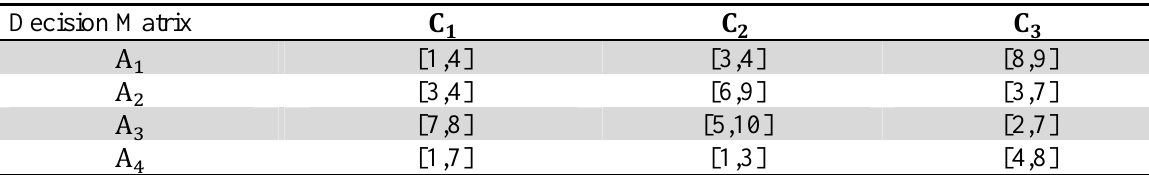
Interval decision matrix